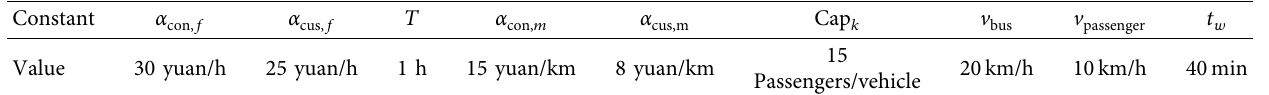
Figure 4: The bus route and passenger distribution area. Table 2: The values of known constants.